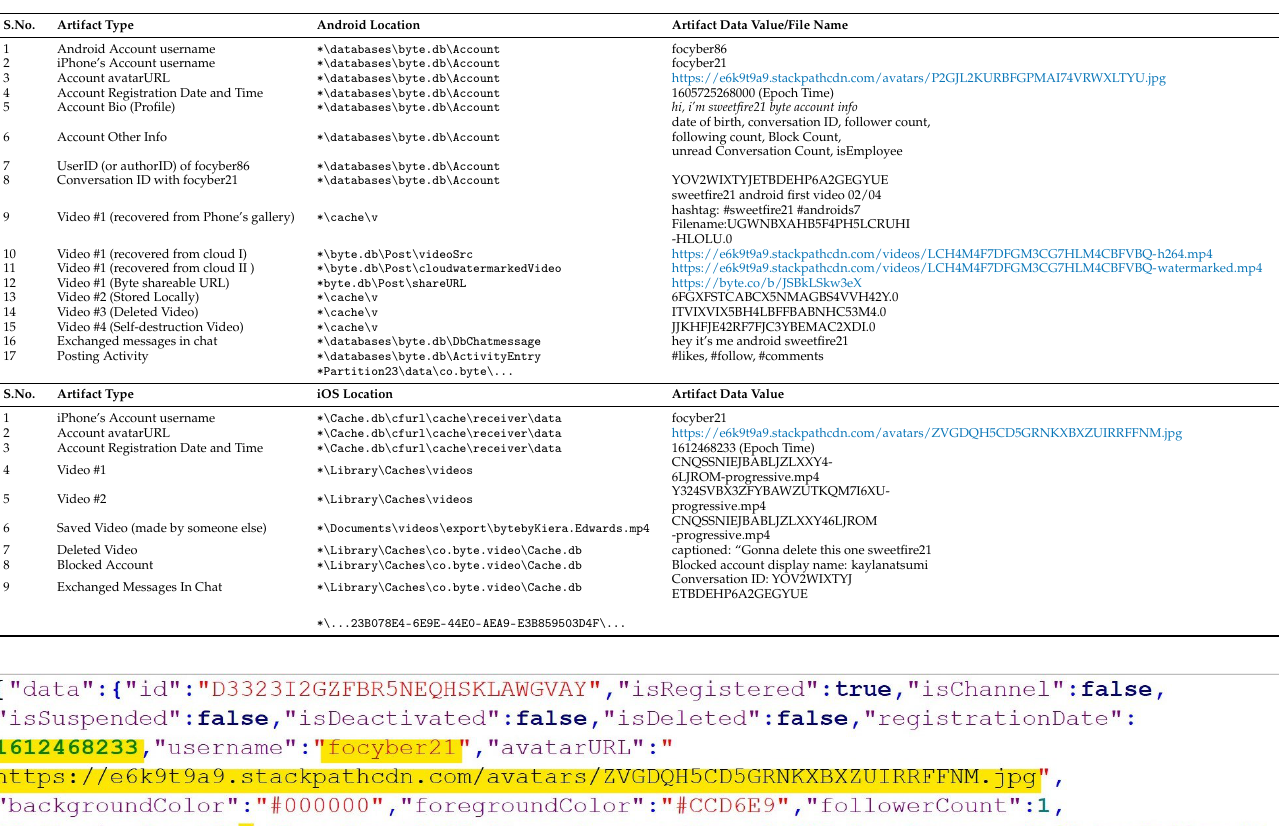
Table 4. Byte Android and iPhone artifacts.